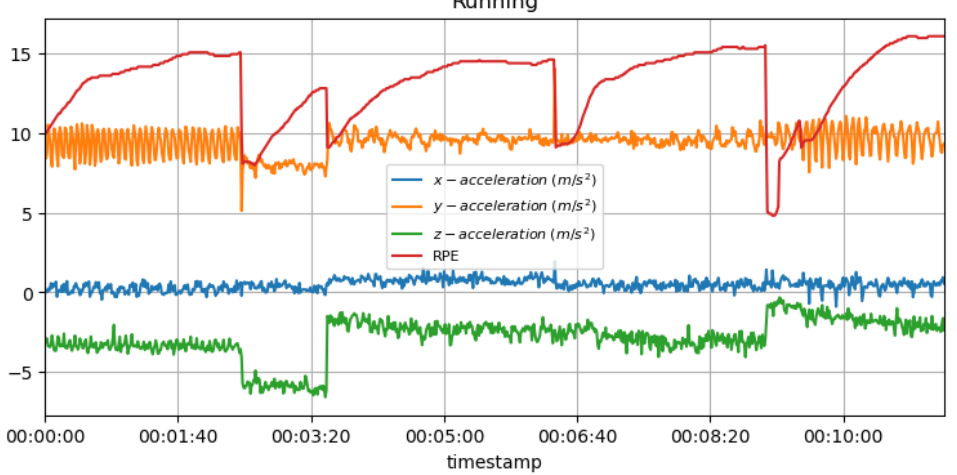
Figure 16. RPE for running activity with acceleration